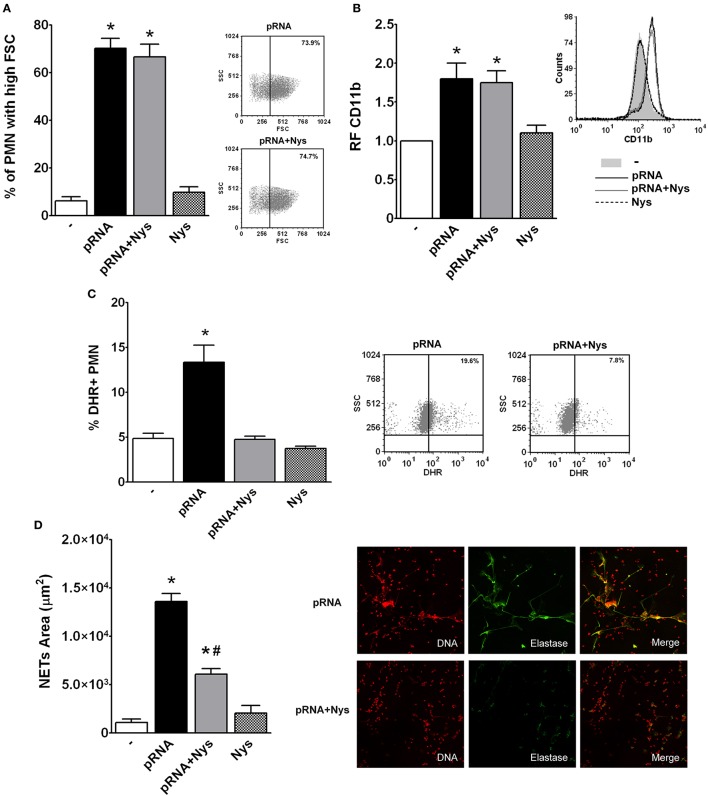
Endocytosis of pRNA is needed for triggering bactericidal responses. Isolated PMN were incubated with pRNA in the presence or absence of the endocytosis inhibitor, Nystatin (Nys). Results were expressed as the mean ± ES, n = 5. (A) Percentage of FSC high PMN. Right panel: Representative dot-plots showing the SSC vs. FSC profiles of PMN incubated with pRNA or pRNA+Nys. (B) Expression of CD11b. Results were expressed as the relative fluorescence (RF) of the MFI of the different treatments with respect to untreated PMN. Right panel: Representative histogram showing the CD11b expression of PMN left untreated or incubated with pRNA, pRNA+Nys, and Nys. (C) ROS generation. Right panel: Representative dot-plots of the percentage of DHR+ PMN are shown in untreated (−) or incubated with pRNA, pRNA+Nys, and Nys. (D) NETs formation. Right panel: Representative microphotographs of confocal images showing PMN from pRNA and pRNA+Nys groups stained for DNA or elastase visualization and the merge of the images (x200). In all cases *p < 0.05 vs. all other groups and #p < 0.05 vs. pRNA.